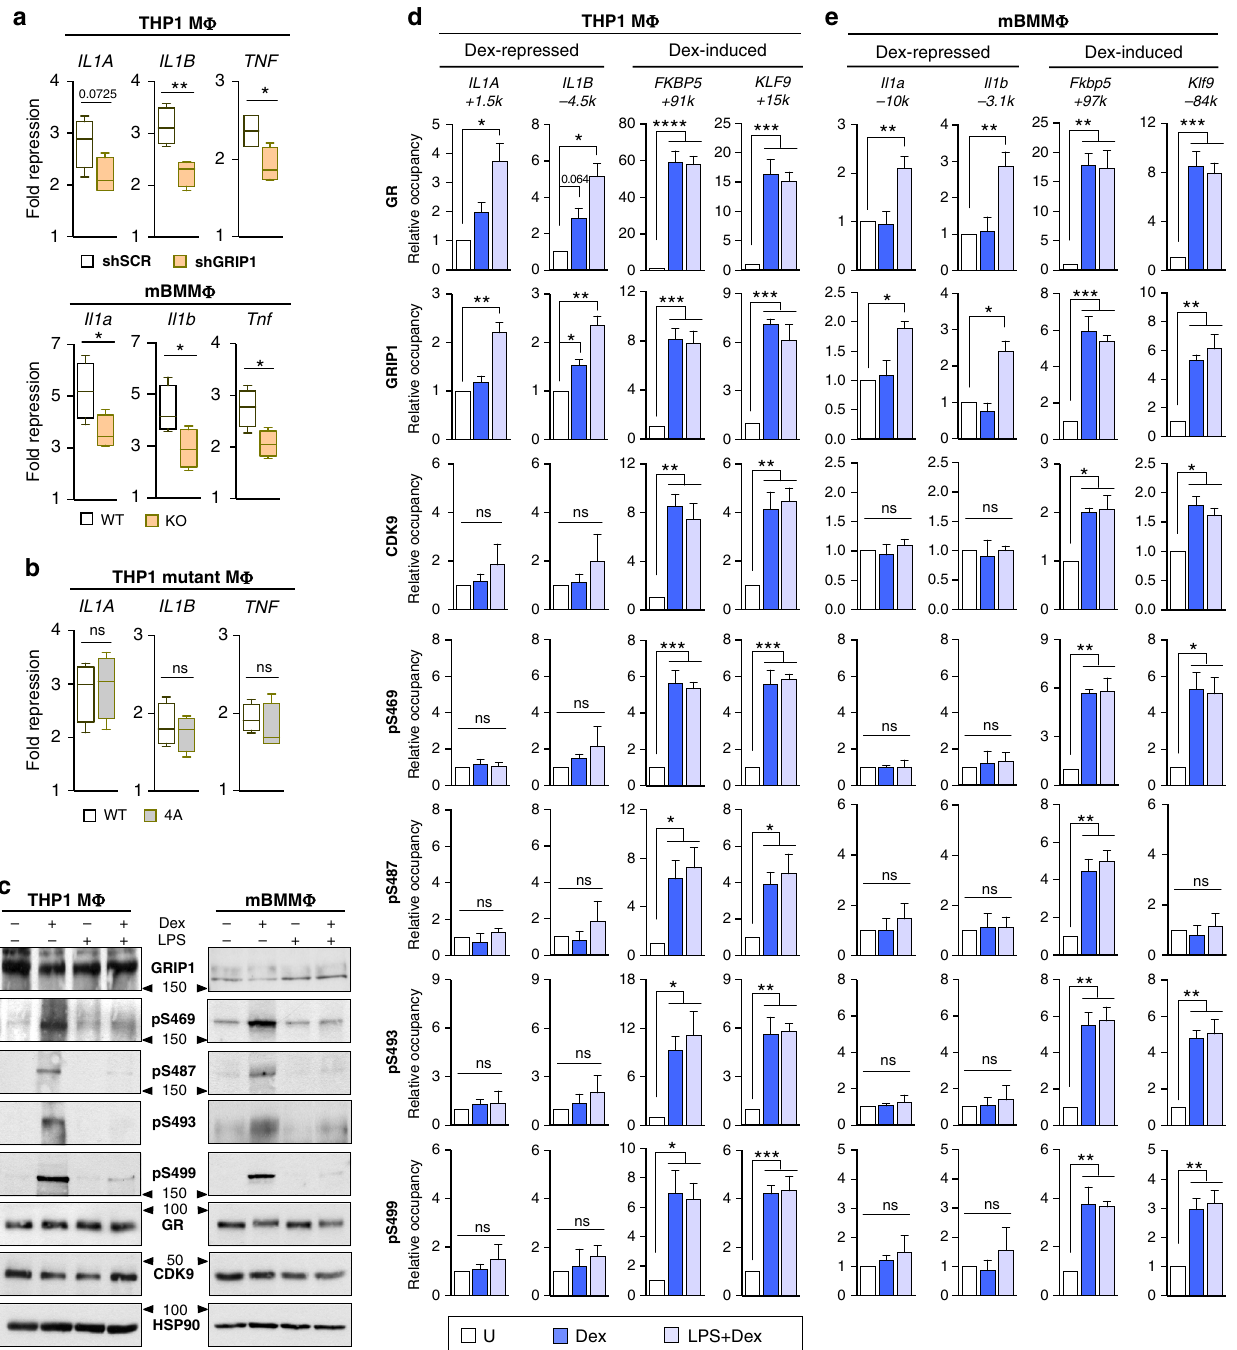
Fig. 6 GRIP1 phosphorylation does not potentiate its GR corepressor function. a THP1 cells (small hairpin scrambled (shSCR) or shGRIP1) or BMM Φ (WT or GRIP1 KO) were treated ± 10 ng ml − 1 LPS and ± Dex for 1 h and the expression of indicated genes was analyzed by RT-qPCR as described in Fig. 1a. “ Fold repression ” was de fi ned as the quotient of the transcript level at lipopolysaccharide (LPS) over LPS+dexamethasone (Dex) condition and is shown as Tukey box-and-whisker plots ( n = 4). b THP1 cells expressing WT or S469A/S487A/S493A/S499A (4A) mGRIP1 were treated as in (a) and fold repression of indicated genes is shown. ns, non-signi fi cant. c THP1 M Φ or BMM Φ were treated ± Dex ± LPS for 2 h, as indicated, and the levels of GRIP1, GRIP1 phospho- isoforms, GR, CDK9 and HSP90 were evaluated by immunoblotting (quanti fi ed in Supplementary Fig. 9d; full-size blots are shown in Supplementary Fig. 10h). THP1 M Φ ( d ) or BMM Φ ( e ) treated with ± Dex ± LPS for 1 h were analyzed for GR, GRIP1, CDK9 and phospho-GRIP1 occupancy by ChIP-qPCR